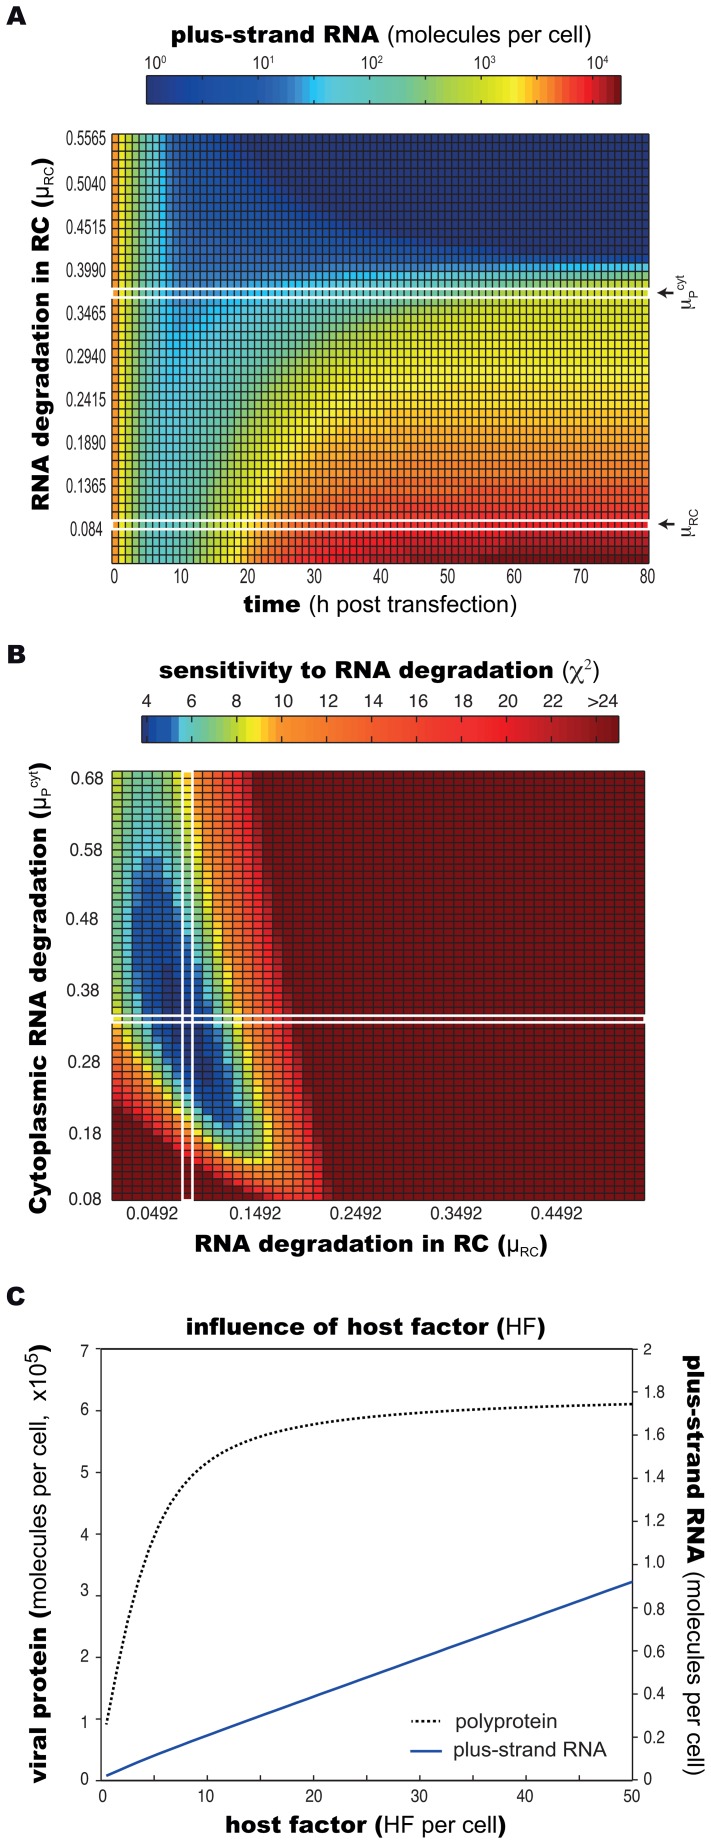
Analysis of the importance of a distinct replicative compartment (RC).(A) Protective effect of replication vesicles: replication dynamics (plus strand RNA shown) at different degradation rates (μRC) of viral RNA inside of the replicative compartment (RC). Actual values for μRC and μPcyt obtained from model calibration are marked in the figure. Different degradation rates are depicted on the y-axis, resulting time courses for positive strand RNA molecules are color-coded along the x-axis. At μRC = μPcyt, viral RNA replication becomes unstable, and efficient replication cannot be sustained. (B) The plot shows the resulting sum of residual squared errors (χ
2) when simultaneously varying the degradation rates μRC and μPcyt. The plot shows that χ
2 increases over five-fold when μRC and μPcyt attain similar magnitudes. (C) Effect of host factor (HF) expression levels on the steady state levels of viral RNA and protein. Plus-strand RNA steady state levels (red line) respond linearly to concentration changes of HF in the range of 1–100 HF “molecules”. Viral polyprotein levels (blue line) show a bi-phasic steady state behavior with an exponential response for up to approx. 20 HF “molecules”, showing saturation thereafter. Note that HF is a hypothetical species likely comprising different host cellular proteins and/or processes; “molecules” therefore does not reflect physical molecule numbers.